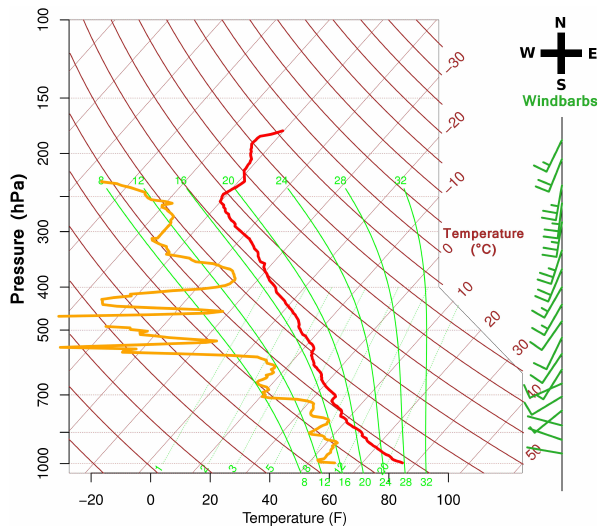
Figure 5. Skew ( T − ln P ) diagram of the radiosonde measure- ments at Uccle station on 29 June 2005 at 12:00UTC (Brussels). The state curve is in red, the dew point curve in yellow, the moist adiabats in green, and the dry adiabats in brown. The windbarbs are presented on the right in dark